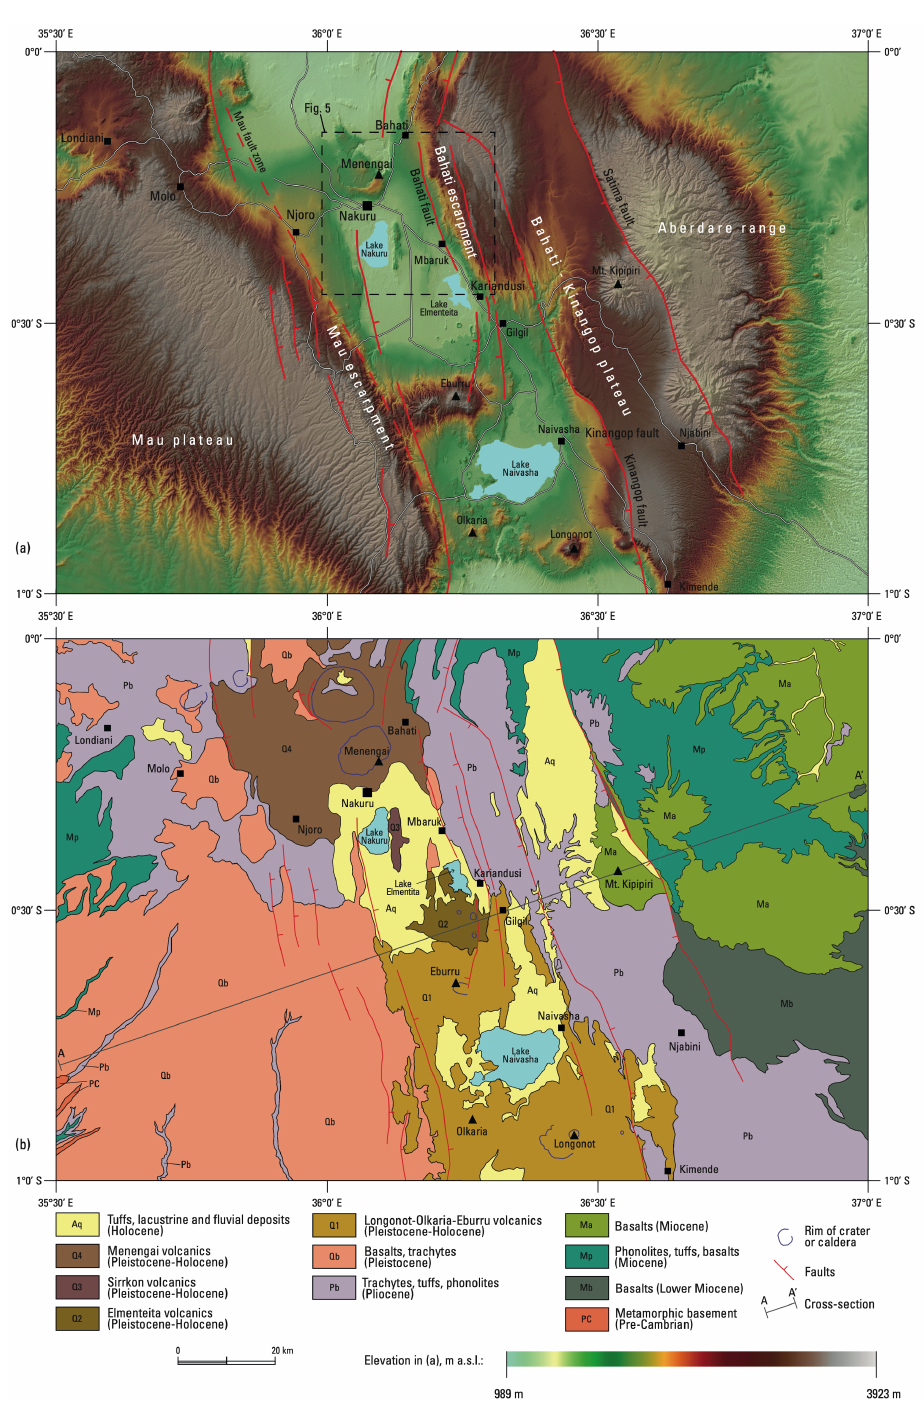
Figure 3. ( a ) Morphology of the Menengai-Longonot and surrounding areas in the central Kenyan rift. ( b ) Geological map of the same area, compiled from maps of Shackleton [28], Thompson and Dodson [29], Thompson [30], McCall [31], Jennings [32], Clarke et al. [33], Williams [34] and original field work. See Figure 1b for location, cross section in Figure